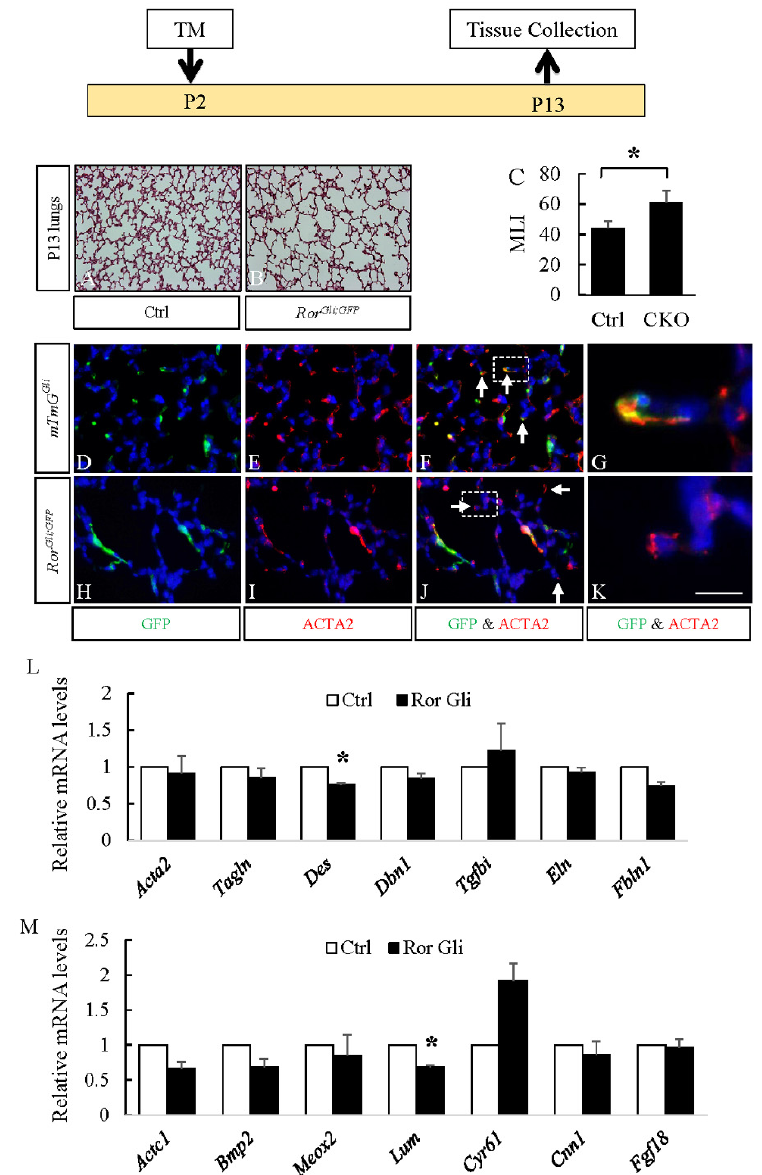
Figure 7. Postnatal inactivation of Ror1 and Ror2 attenuated alveologenesis. Top: Schematic of the experimental plan. A – B : H&E staining of P13 control ( A ) and Ror Gli;GFP ( B ) lungs. C : Mean linear intercept (MLI) of P13 control and Ror Gli;GFP (CKO) lungs. D – K : Immunostaining of GFP (green) and ACTA2 (red) in P13 mTmG Gli ( D – G , control) and Ror Gli;GFP ( H – K ) lungs. Panels G and K show higher magnification views of boxed areas in F and J, respectively. Nuclei are counterstained with DAPI. Scale bars ( K ): 200 µ m for A and B , 50 µ m for D – F and H – J , 11 µ m for G and K. L – M : Relative mRNA for myofibroblast enriched genes and cell migration genes in P13 Ror Gli;GFP (Ror Gli) lungs compared to control lungs by real-time RT-PCR analysis. Data represent the mean ± SEM. * indicates p < 0.05. n = 3.